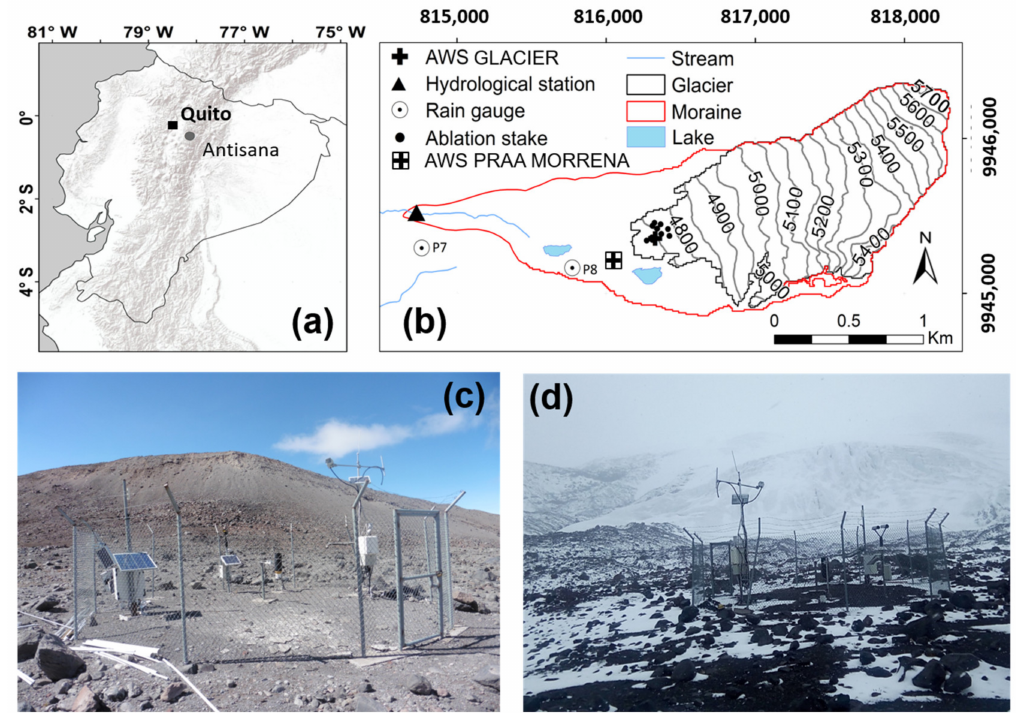
Figure 1. Location map of monitoring stations used for the Antisana glacier 12. ( a ) Antisana glacier in the northern Andes of Ecuador, ( b ) Moraine basin, ( c , d ) PRAA-Morrena station for two seasons, November 2017, and June 2019,